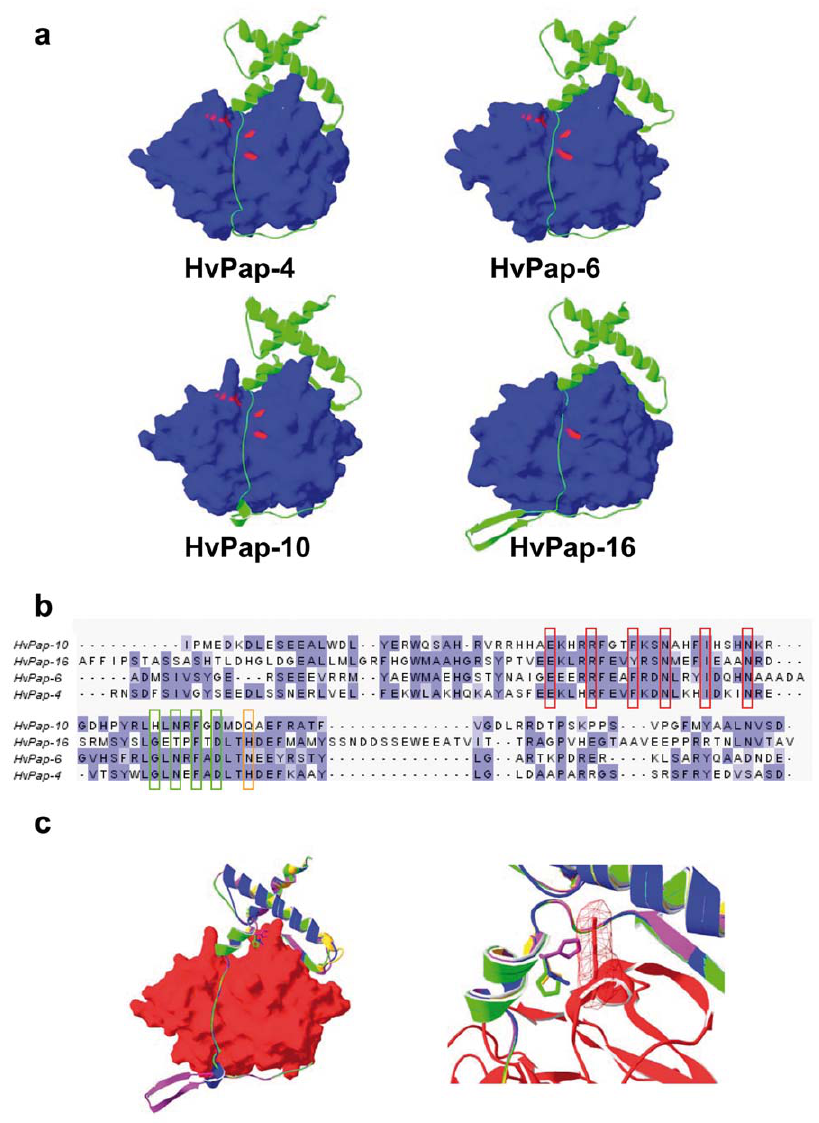
Figure 3. Structure-sequence analysis of barley L-like cathepsins. (a) Homology models of barley cathepsin L-like peptidases created using SWISS-MODEL. The propeptides (green) and their corresponding mature enzymes (blue; catalytic triad residues in red) are shown. (b) Alignment of the amino acid regions of the propeptides from barley L cathepsins. Alignment was generated using the MUSCLE program. The location of residues belonging to the conserved ERFNIN and GNFD motifs (red and green boxes), and the position of a variable key amino acid putatively involved in the interaction propeptide-HvPap-10 enzyme (orange box) are indicated. (c) Ribbon plots showing the structural overlay of three-dimensional models for propeptides from HvPap-4 (green), HvPap-6 (orange), HvPap-10 (blue) and HvPap-16 (purple) peptidases and their interaction with the homology model for HvPap-10 (red). Amino acid residues in position 99 (HvPap-10 numbering) are depicted in stick mode. Close-up image shows the molecular surface of K277 of HvPap-10 peptidase, which is potentially involved in a steric clash with the side chain of H108 of the